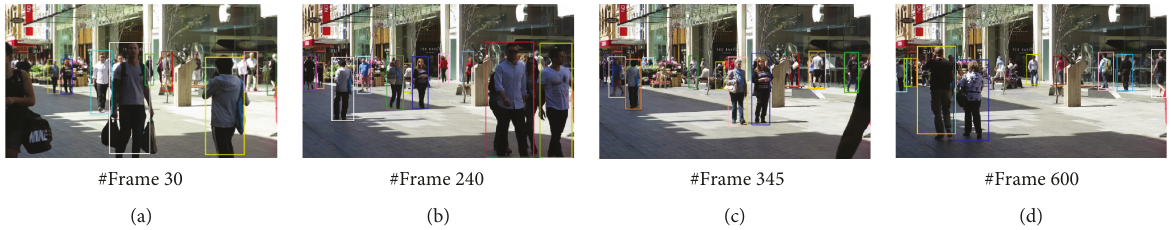
Figure 8: Qualitative tracking results of our tracker on ADL-Rundle-3.